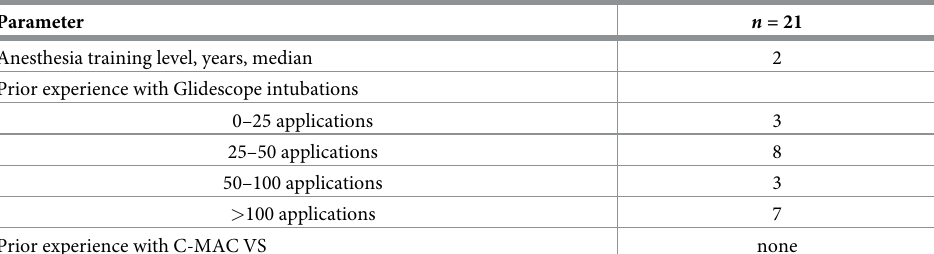
Table 1. Characteristics and intubation experience of participants.